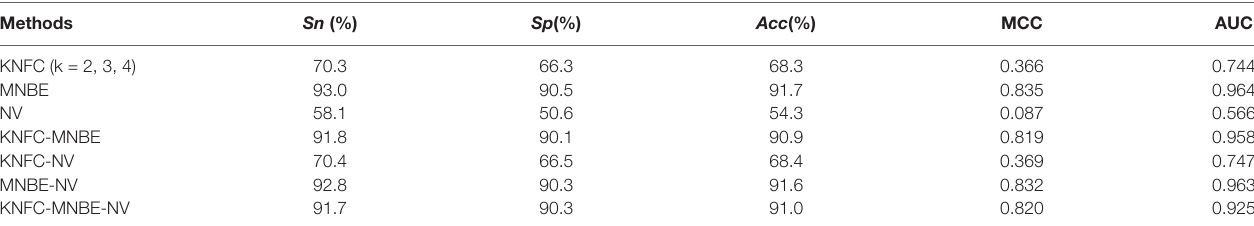
TABLE 2 | Predictive performances of KNFC, MNBE, and NV.